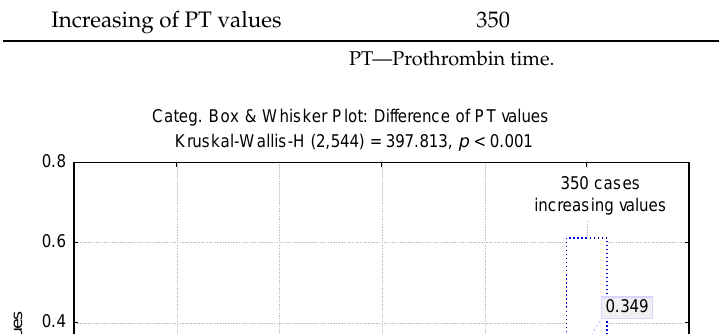
Categ. Box & Whisker Plot: Difference of PT values